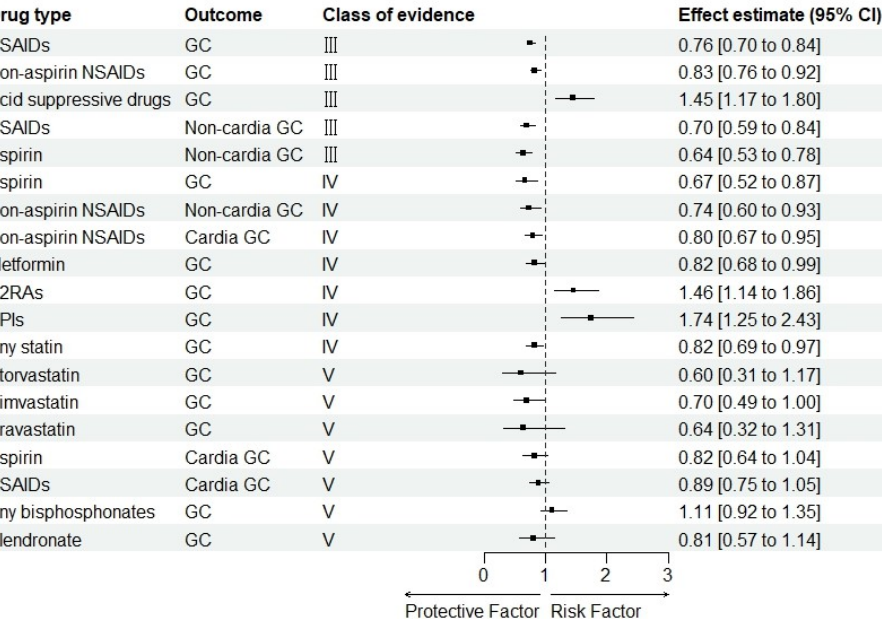
Figure 4. Summary estimates of commonly used drugs and GC risk by class of evidence. Abbrevia- tions: GC, gastric cancer; NSAIDs, non-steroidal anti-inflammatory drugs; H2RAs, Histamine 2-re- ceptor antagonist; PPIs, proton pump inhibitors; CI, confidence interval. 2-receptor antagonist; PPIs, proton pump inhibitors; CI, confidence